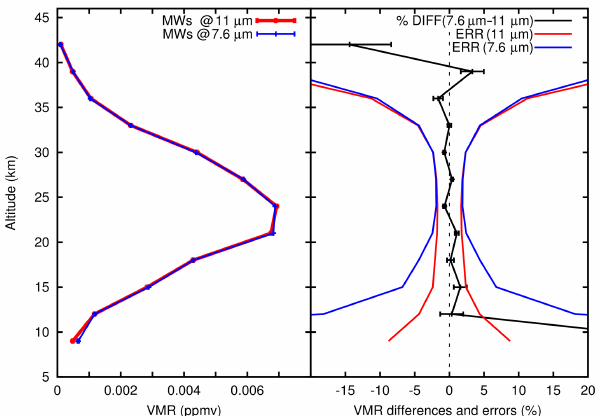
Figure 1. Left panel: average HNO 3 VMR profiles from MIPAS measurements acquired on 24 January 2003, using the MIPAS-2015 linelist. Retrievals using MWs in the 11µm region (red line) and in the 7.6µm region (blue line). Right panel: mean percentage differ- ences between HNO 3 profiles retrieved from the 7.6 and 11µm re- gions (black line). The red and the blue lines show the noise error of the individual retrievals using MWs in the 11 and in the 7.6µm spectral